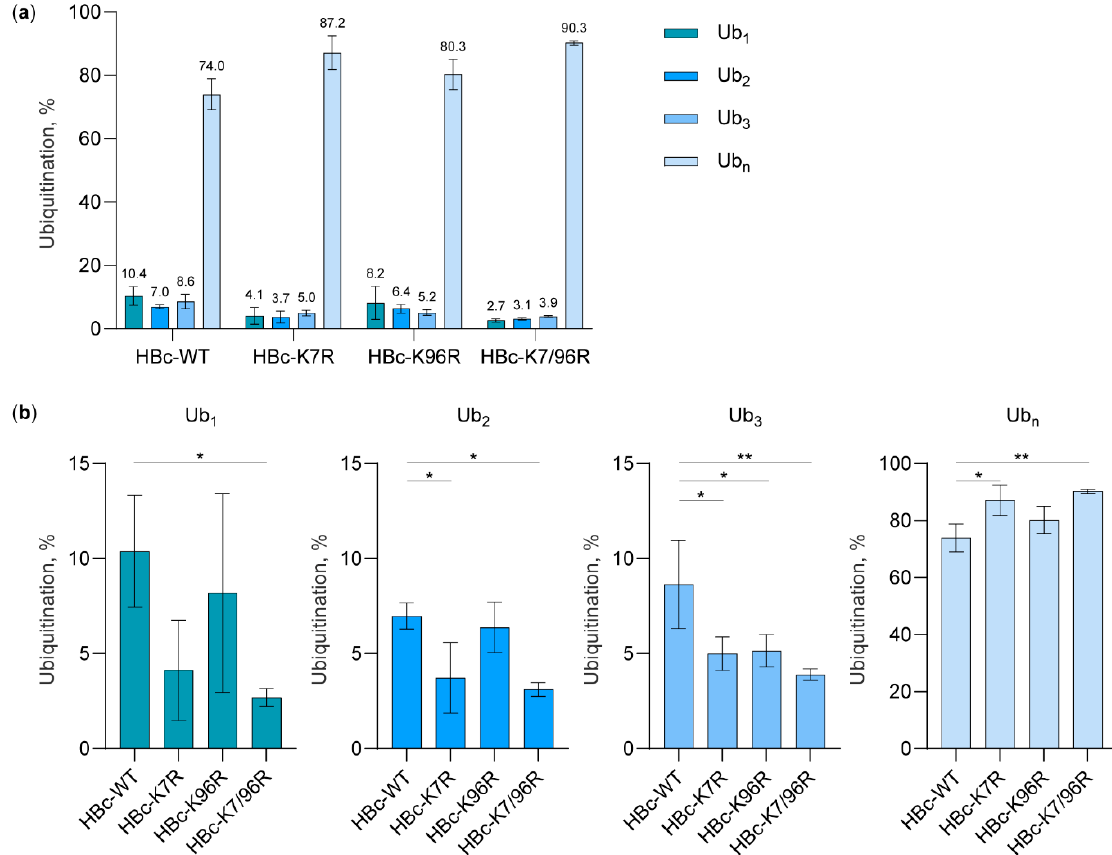
Figure 4. Lysine residue at position 7 is important for HBc ubiquitination. ( a ) Ratio of Ub 1 , Ub 2 , Ub 3 , and Ub n in each HBc variant (HBc-WT, HBc-K7R, HBc-K96R, HBc-K7/96R); ( b ) Prevalence of each ubiquitination for different HBc variants (HBc-WT, HBc-K7R, HBc-K96R, HBc-K7/96R). The results are based on three independent experiments and normalized to the expression level of the respective HBc variant. The total ubiquitination of each HBc variant was set to 100%. Data is shown as mean ± standard deviation. * p ≤ 0.05; ** p < 0.01 obtained by ordinary one-way ANOVA followed by Dunnett’s test for multiple comparisons.